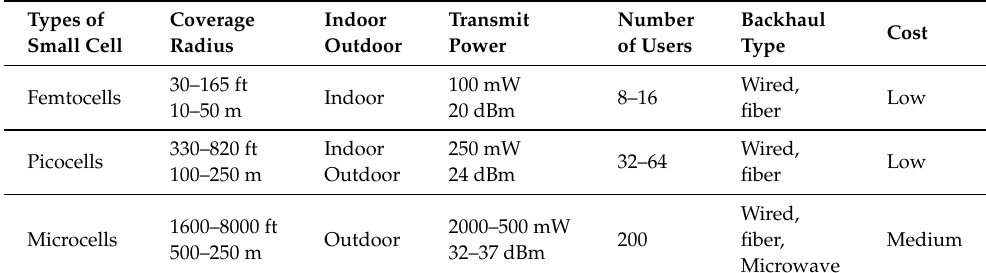
Table 12. Types of Small